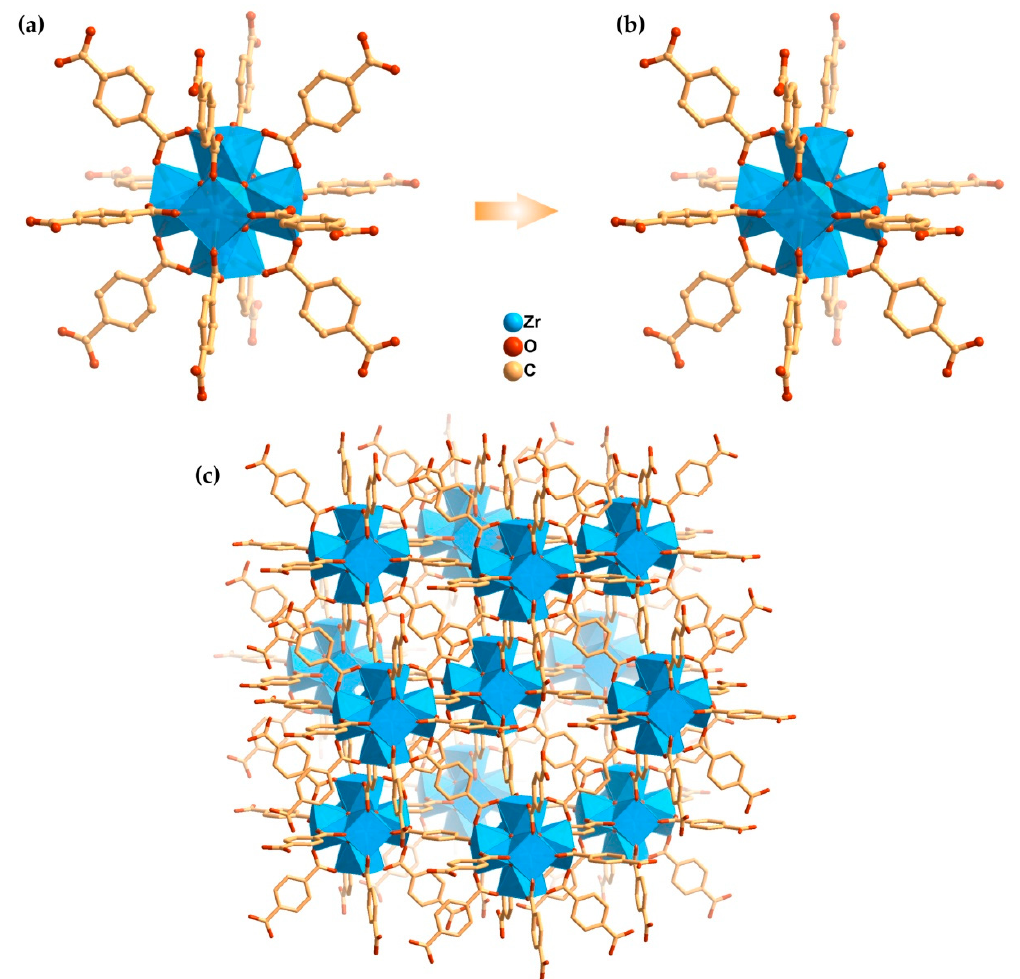
Figure 1. ( a ) Defect-free [Zr 6 O 4 (OH) 4 ] cluster centre coordinated by 12 benzenedicarboxylate (bdc) ligands in the structure of Uio-66(Zr) and ( b ) the centre with a defect site; ( c ) 3D porous structure of MOF UiO-66(Zr). H-atoms were omitted for clarity proposes. Images prepared from the CIF file obtained from CDS with code RUBTAK04 and reported by Trickett and co-workers